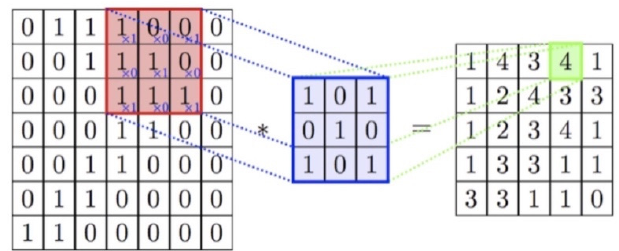
Figure 4. Calculation process of a filter in the convolutional layer. The first matrix is the input, the middle one is the filter, and the right one is the result. The highlighted regions show the calculation process of a step taken by the filter.